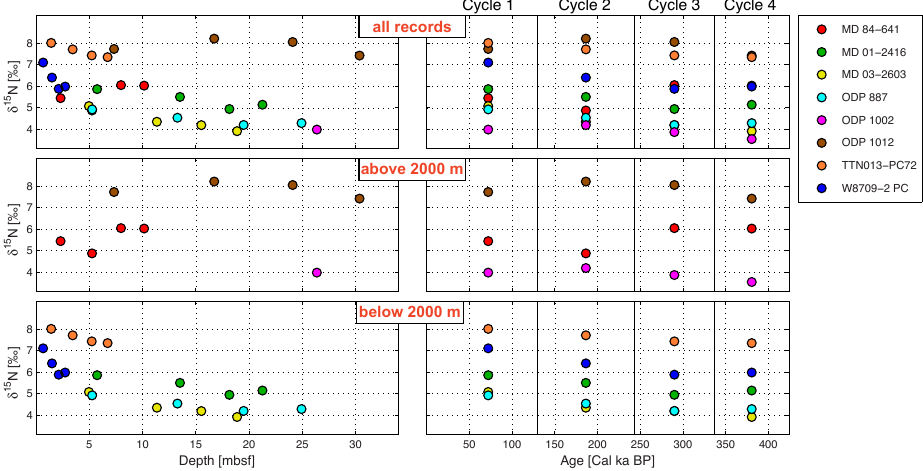
Fig. 8. Plots of δ 15 N versus depth and age for each of the eight records that span at least four glacial–interglacial cycles (i.e. 14 to 424ka). δ 15 N is binned according to the four glacial–interglacial cycles. The top panels show binned δ 15 N for all eight records versus depth (left) and versus age (right). The middle panels show only those records from sites shallower than 2000m water depth, while the bottom panels only those from sites deeper than 2000m water